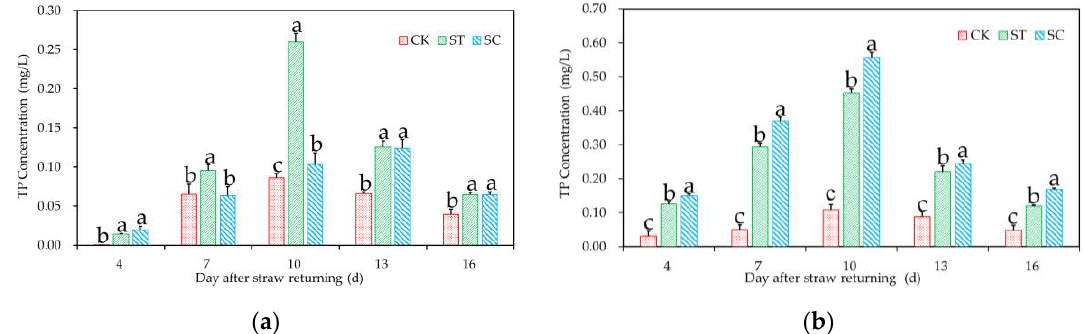
Figure 2. Concentration of total phosphorus (TP) in field water at di ff erent times. ( a ) Surface water. ( b ) 0–10 cm soil water. Note: Values followed by the same letter within the same treatment are not significantly di ff erent based on the LSD multiple range test ( p ≤ 0.05). The letters a, b, c represents 5% significant level. The same letter of two data indicates that there is no significant di ff erence between them. While di ff erent letters indicate that there is significant di ff erence between